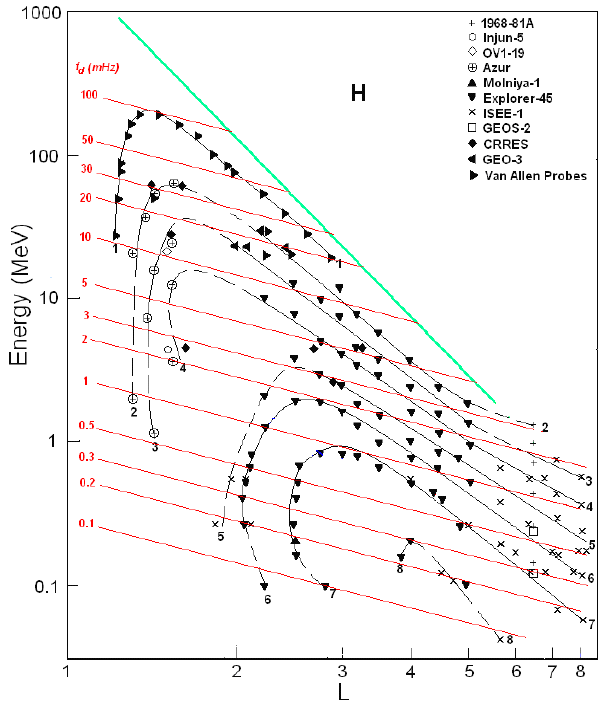
Figure 1. Distribution of the differential fluxes J in the { E,L } space for protons with α 0 ≈ 90 ◦ near maxima of the solar activity (from Kovtyukh, 2020). Data from satellites are associated with different symbols. The numbers on the curves refer to the values of the deci- mal logarithms of J . Fluxes are given in units of (cm 2 ssrMeV) − 1 . The red lines correspond to the drift frequency f d (mHz), and the green line corresponds to the maximum energy of the trapped pro-